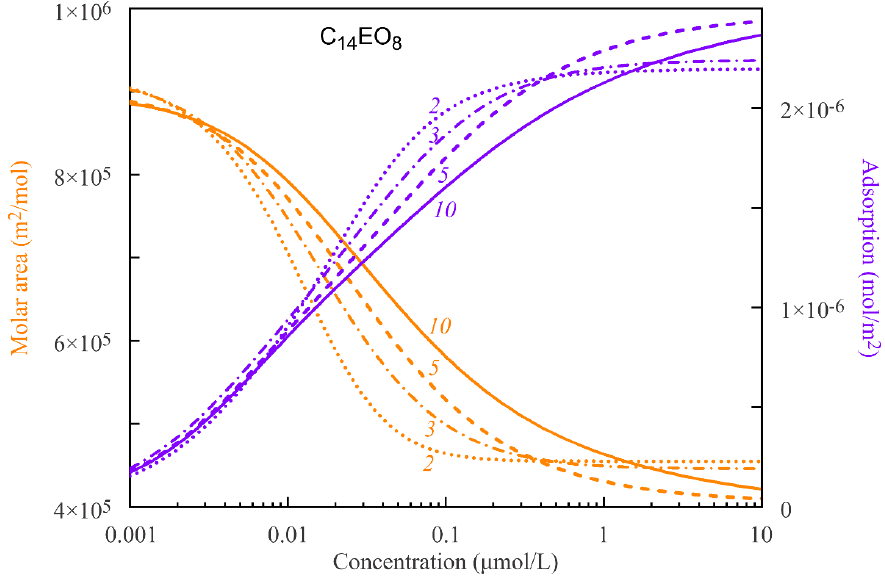
Figure 3. Average molar area (orange curves) and total adsorption (violet curves) for C 14 EO 8 calcu ‐ lated assuming various number of segments: s = 2, 3, 5, and 10, represented by dotted, dash ‐ dotted, dashed, and solid curves, respectively, with the parameters listed in Table 2. For details see text.